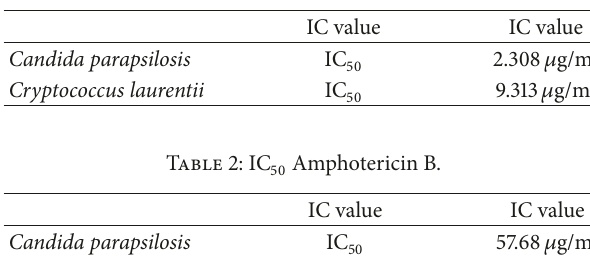
Table 1: IC 50 thymoquinone.